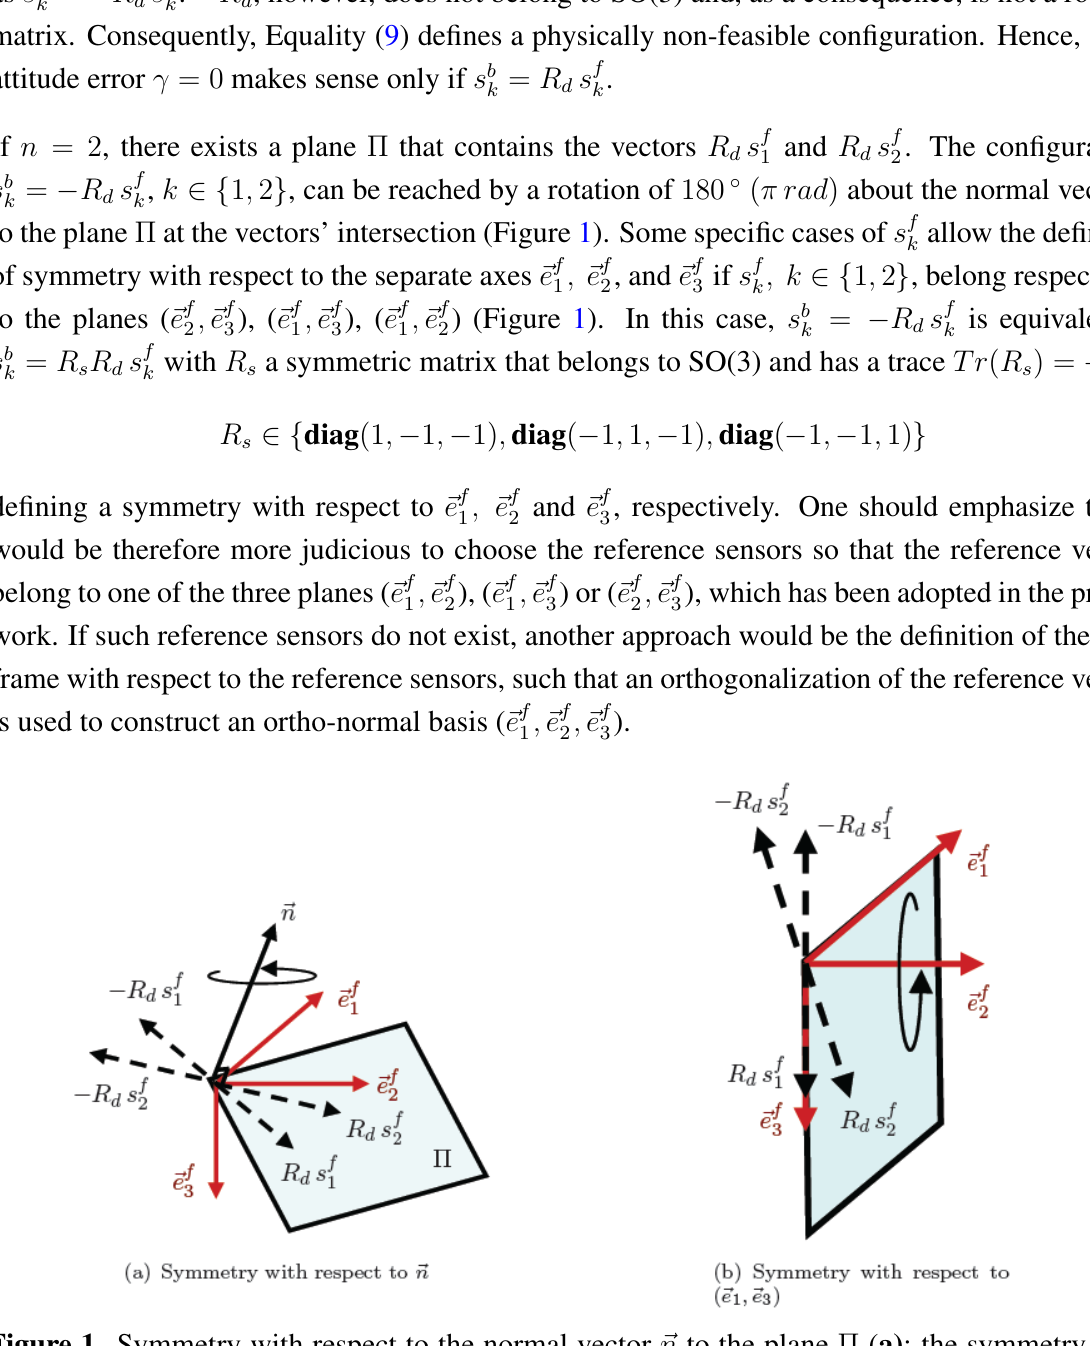
, (cid:126)e f ) ( 1 3